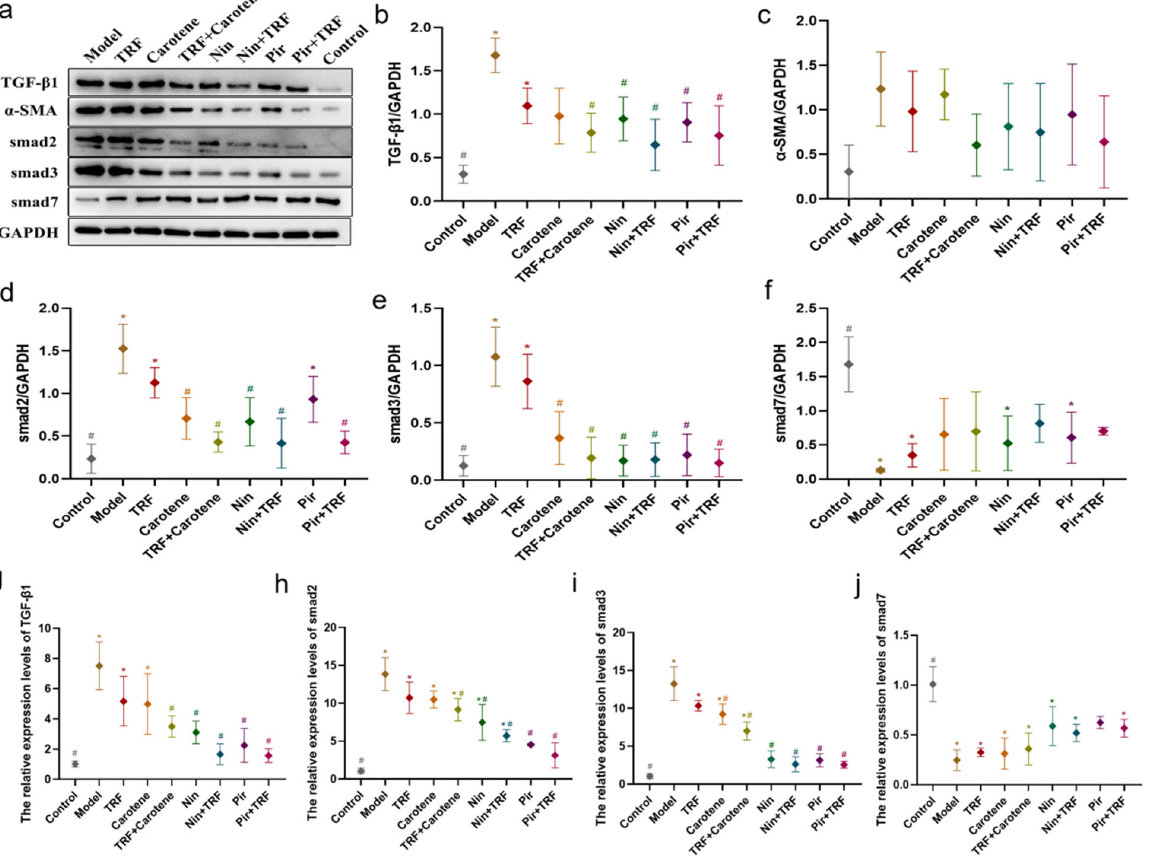
Figure 9. PF was protected by TRF via the inhibition of the TGF ‐β /Smad signaling pathway: WB analysis showed the expressions of fibrosis proteins induced by BLM in SD rats were decreased ( a – f ), as seen in TGF ‐β 1 ( b ), Smad2 ( c ), Smad3 ( d ), Smad7 ( e ) and α‐ SMA ( f ) in the lung samples; n = 3; ( g – j ) Representative statistical analysis of TGF ‐β 1 ( g ), Smad2 ( h ), Smad3 ( i ) and Smad7 ( j ) in mRNA by RT ‐ qPCR; n = 3. Note: * represents p < 0.05 in comparison to the control group; # represents p < 0.05 in comparison to the model group.